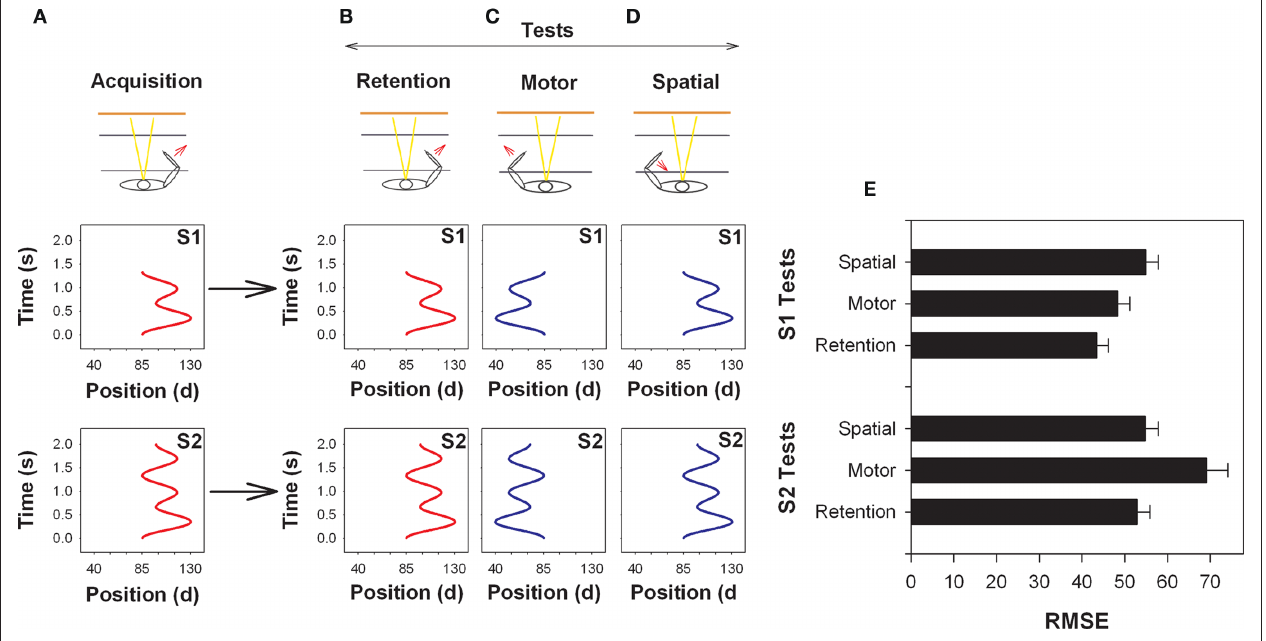
displayed. Note that the start position between the upper and lower arm in this task was 85 ° . RMSE means and SEs by test is provided in (e) . (Redrawn from Kovacs et